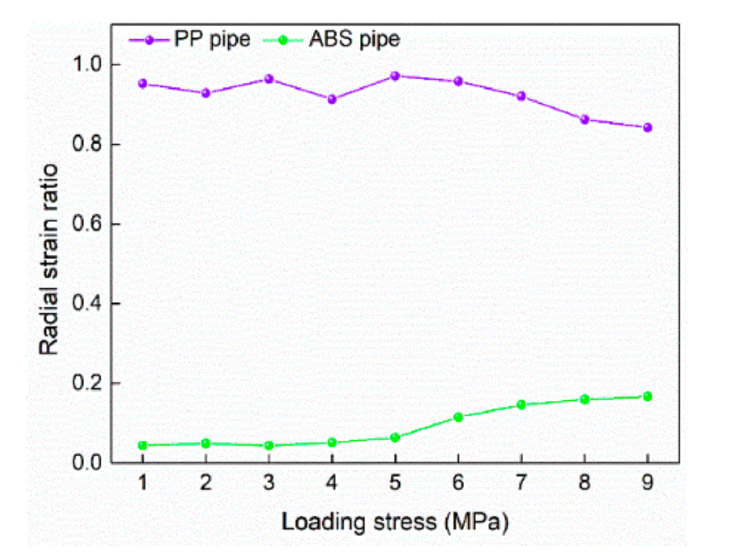
Figure 6. Radial strain ratios of PP screen pipe and ABS screen pipe to PVC screen